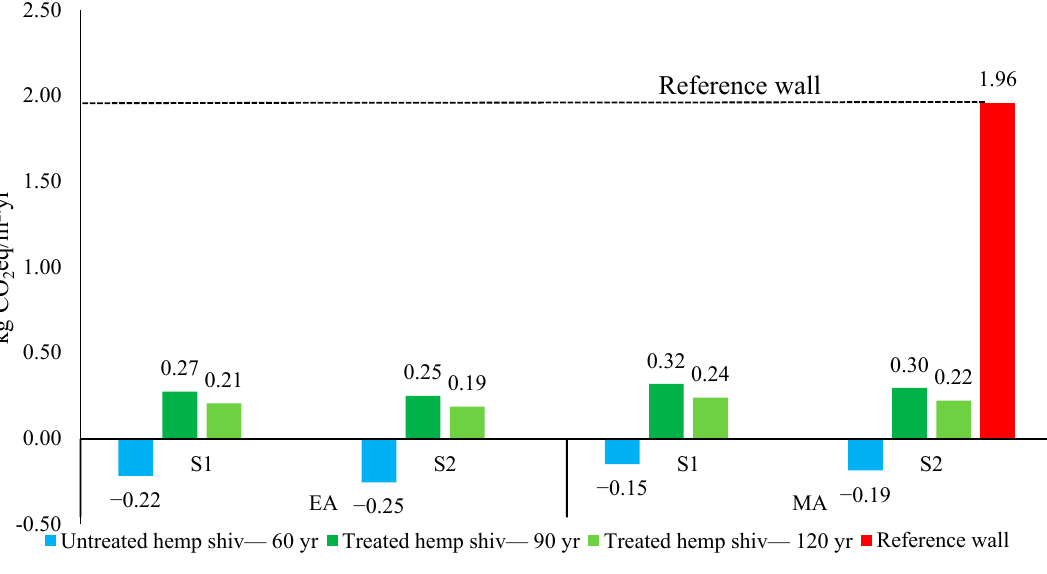
Figure 6. Carbon footprint of 1 m 2 hempcrete wall compared to reference wall. EA and MA show the results based on economic and mass allocation. S1 and S2 are waste scenarios (S1—composting hemp shiv and landfilling the rest, S2—landfilling all the materials).